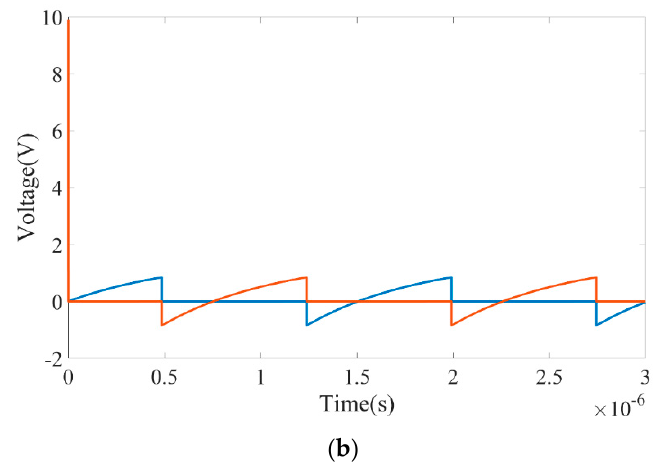
Figure 9. The cells are in wake-up mode after coupling. ( a ) is configuration of two coupled cells. In ( b ), we see there is oscillation in the circuit.